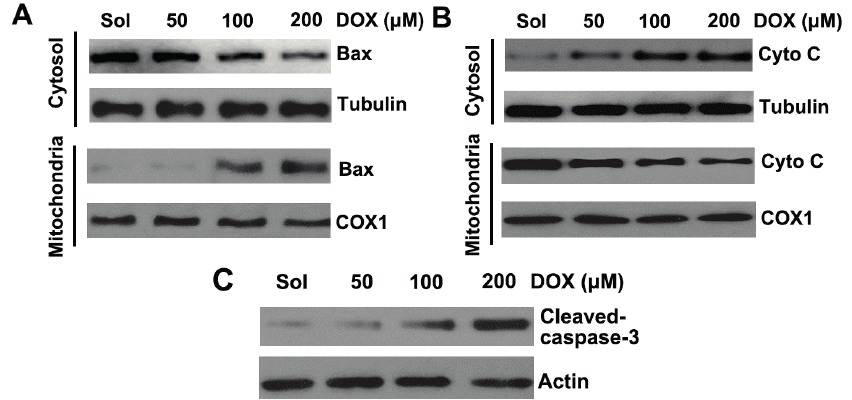
Figure 2. DOX induced mitochondrial translocation of Bax, cytochrome C release, and caspase-3 activation. ( A , B ) Platelets were incubated with different concentrations of DOX or solvent. Treated platelets were lysed, and cytosol and mitochondrial fractions were isolated and analyzed by Western blot with anti-Bax ( A ), and anti-cytochrome C antibodies ( B ), COX1 and tubulin were used as internal controls; ( C ) Platelets were incubated with different concentrations of DOX or solvent. Treated platelets were lysed and analyzed by Western blot with anti-caspase-3 antibody. Actin levels were assayed to demonstrate equal protein loading. Representative data of three independent experiments are